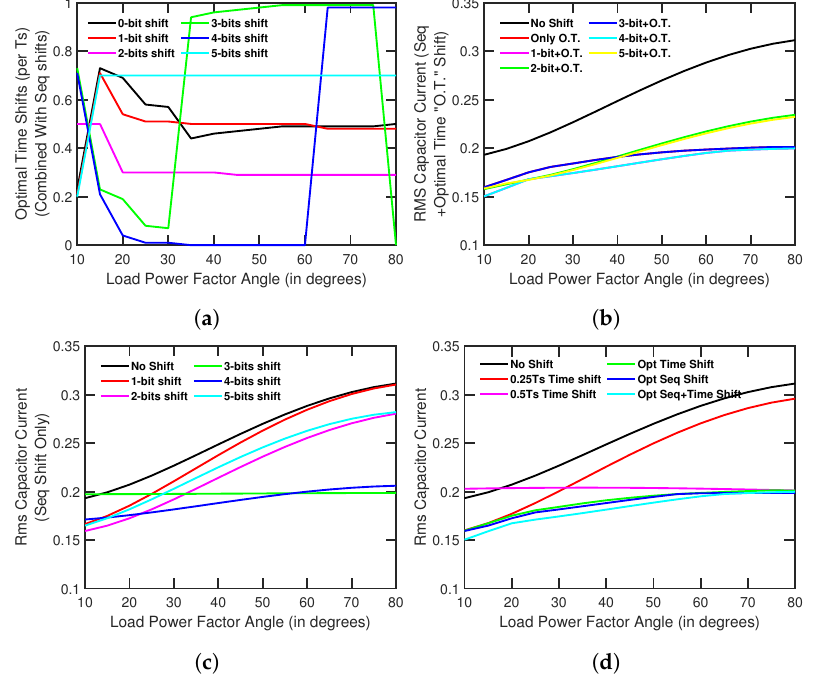
Figure 13. For equal load, a mod.index = 1 and a phase difference of 30 ◦ . ( a ) Optimal time shifts (com- bined with seq shifts). ( b ) i c,rms for seq+opt time shifts. ( c ) i c,rms for only seq shifts. ( d ) Comparative i c,rms for different interleaving